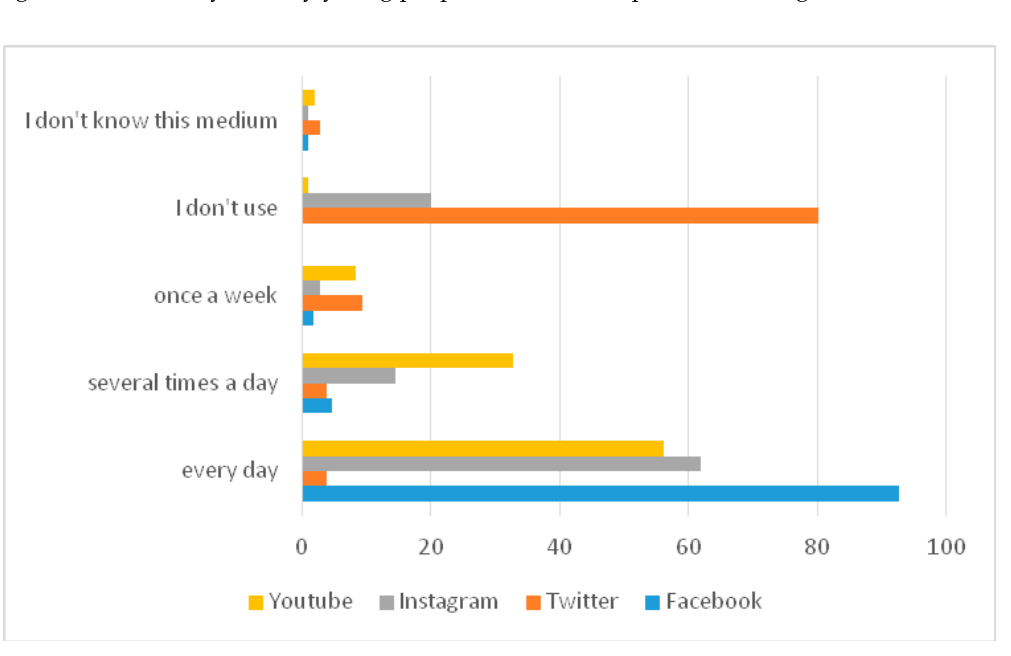
Figure 1. Frequency of use of particular social media [%]. Source: own work.